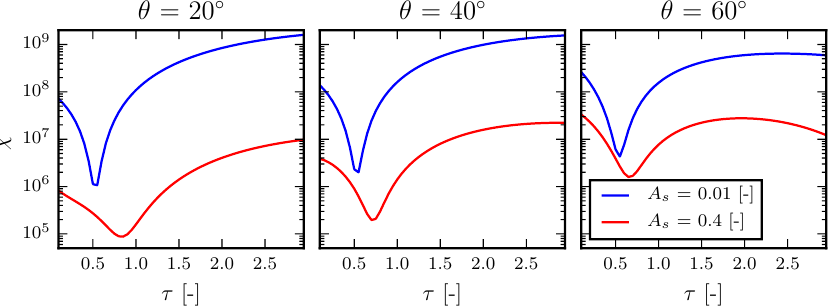
Figure 6. Cost function ( χ 2 ) for retrieving aerosol optical thickness as a function of aerosol optical thickness per iteration ( τ ) for a dark and a bright surface. The true aerosol optical thickness is 0.5, and the aerosol layer is situated at 600hPa with a 50hPa layer thickness. The aerosol single-scattering albedo is fixed at 0.95, for a Henyey–Greenstein aerosol phase function with g = 0 . 7. The solar zenith angle is fixed at 45 ◦ for varying viewing angles as specified in the plot titles. The relative azimuth angle is 0 ◦ . The state vector also contains aerosol layer height, whose a priori value is fixed at